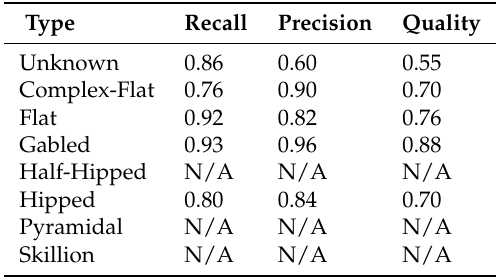
Table 8. Results for recall, precision, and quality evaluation metrics for Test Set